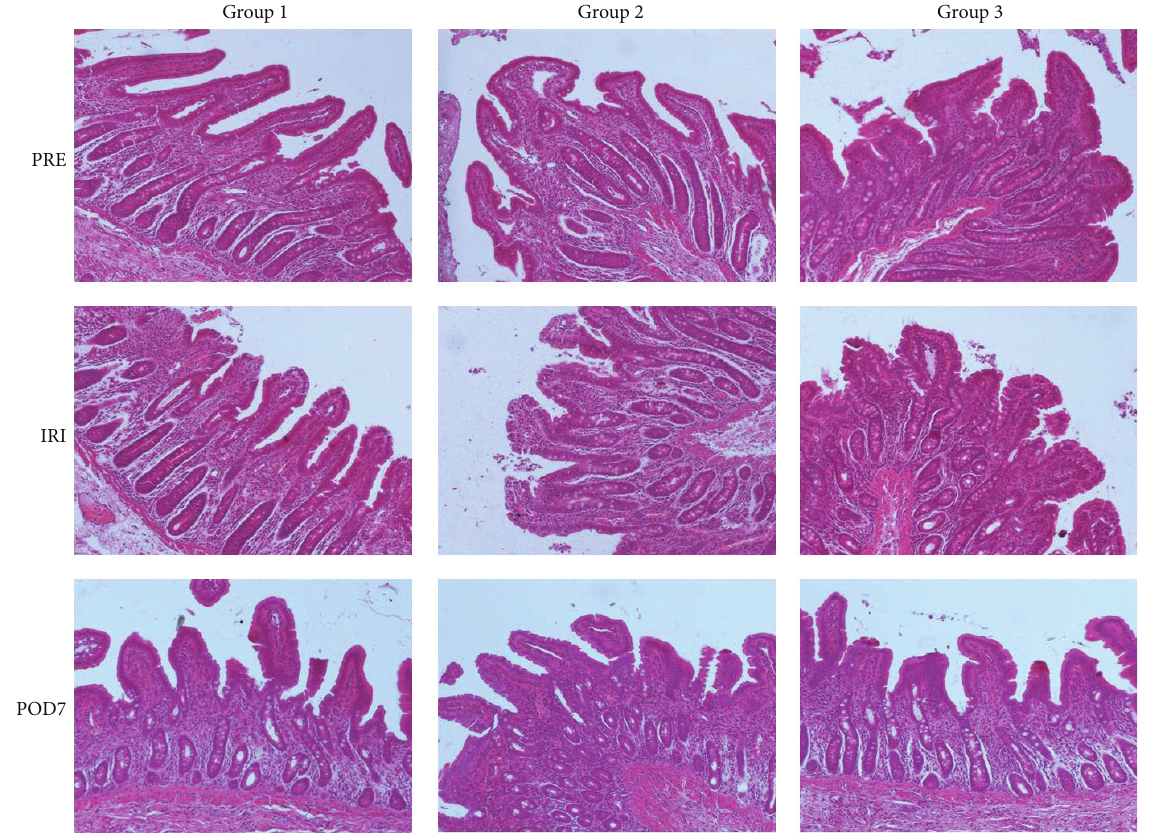
Figure 1: Morphologic changes of small bowel mucosa (HE × 100).